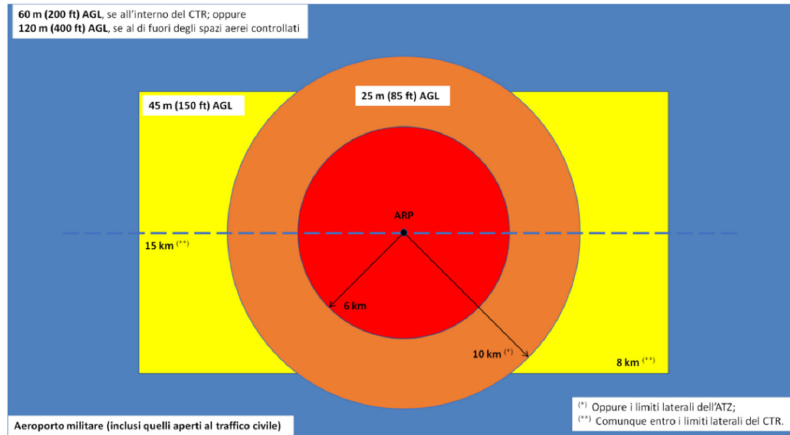
Figure 11. Maximum UAV flight height for a military airport (ATM09 Note).